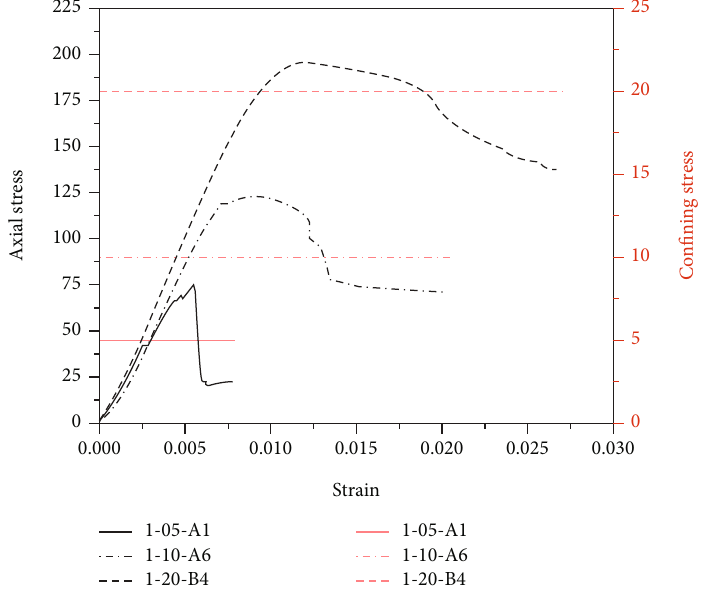
Figure 4: Axial stress/con fi ning pressure-strain relations of Scheme 1 under di ff erent con fi ning pressures.